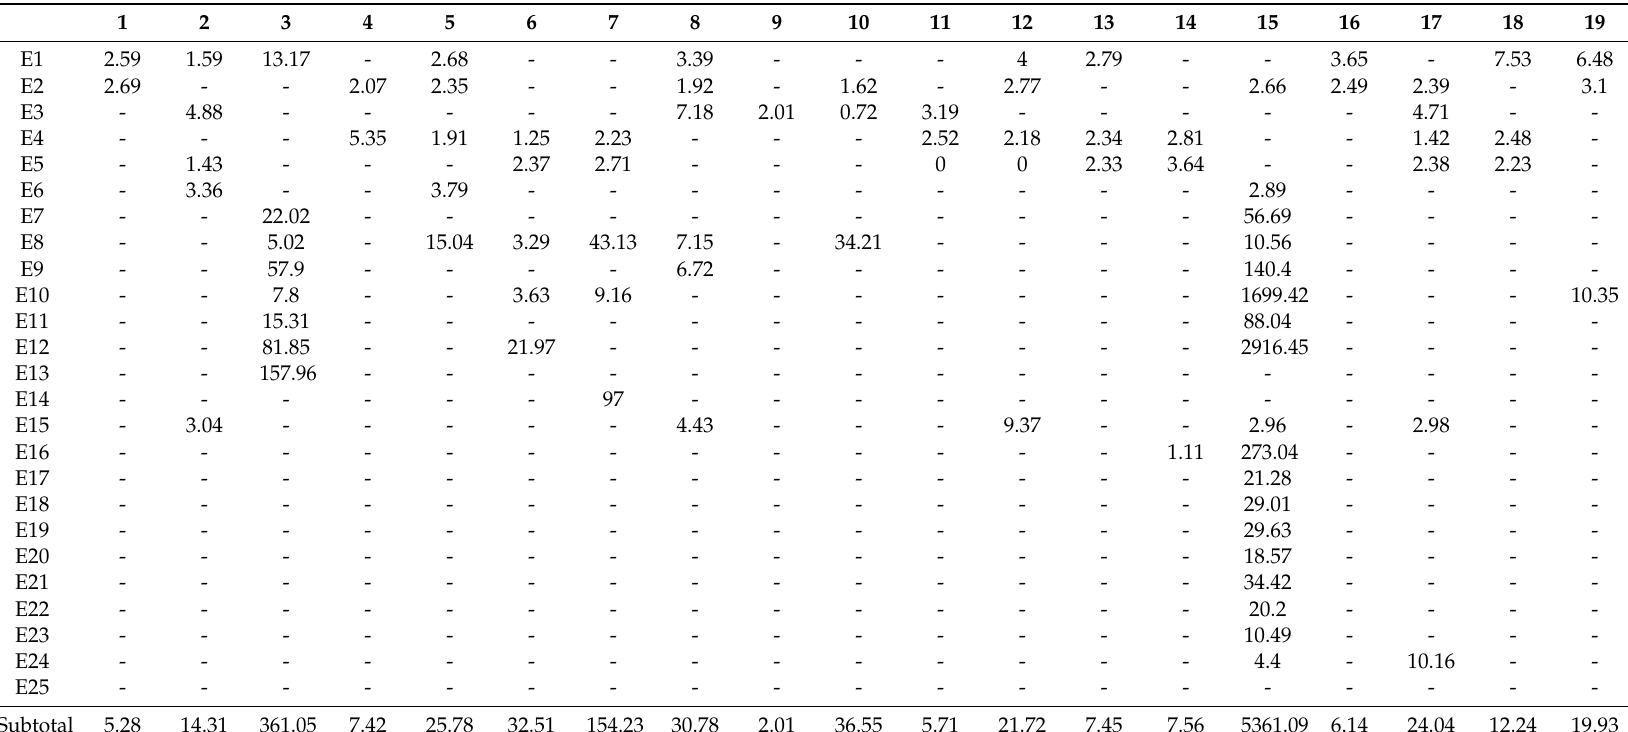
Table 6. Concentrations ( µ g/kg fresh weight (FW) equivalent of nonyl acetate) of volatile esters in 37 mango